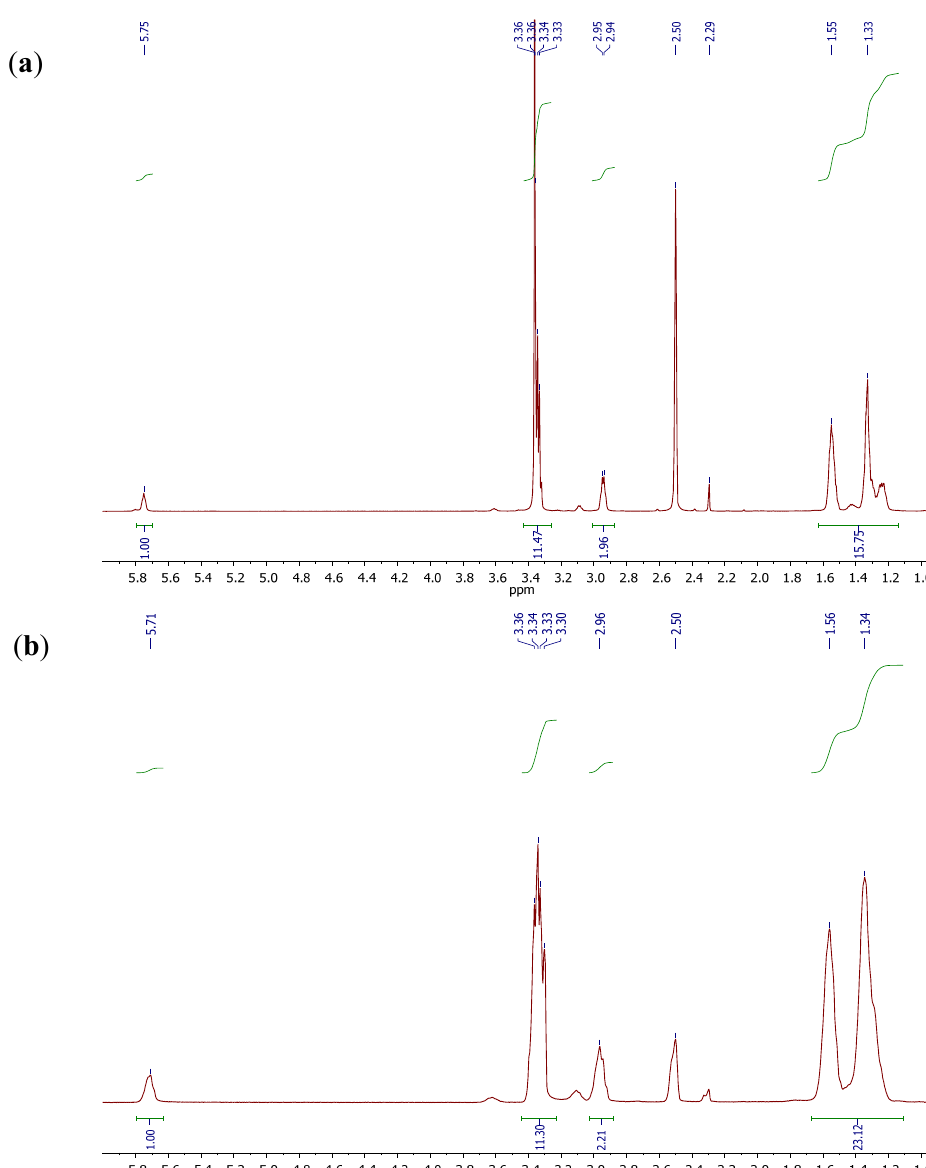
Figure 2. 1 H-NMR spectra for ( a ) CTIN-1 and ( b )